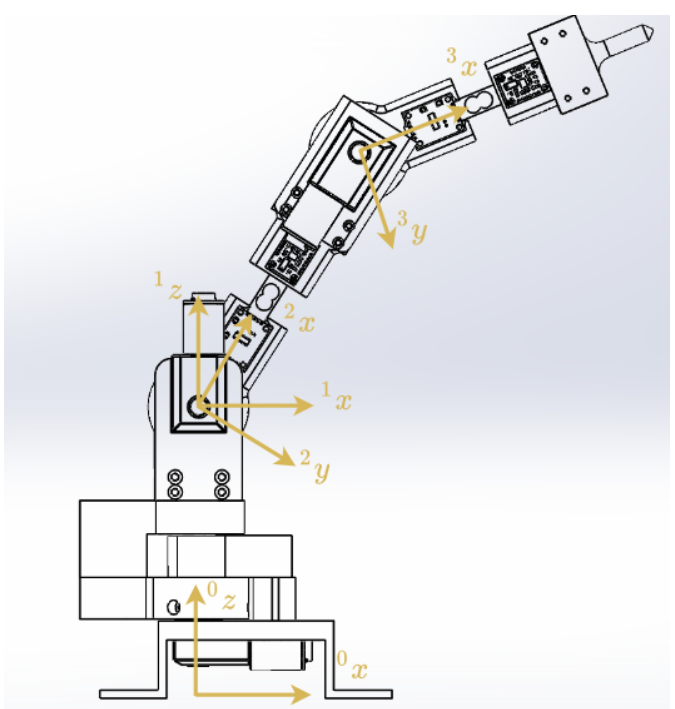
Figure 4. Manipulator sketch with coordinate